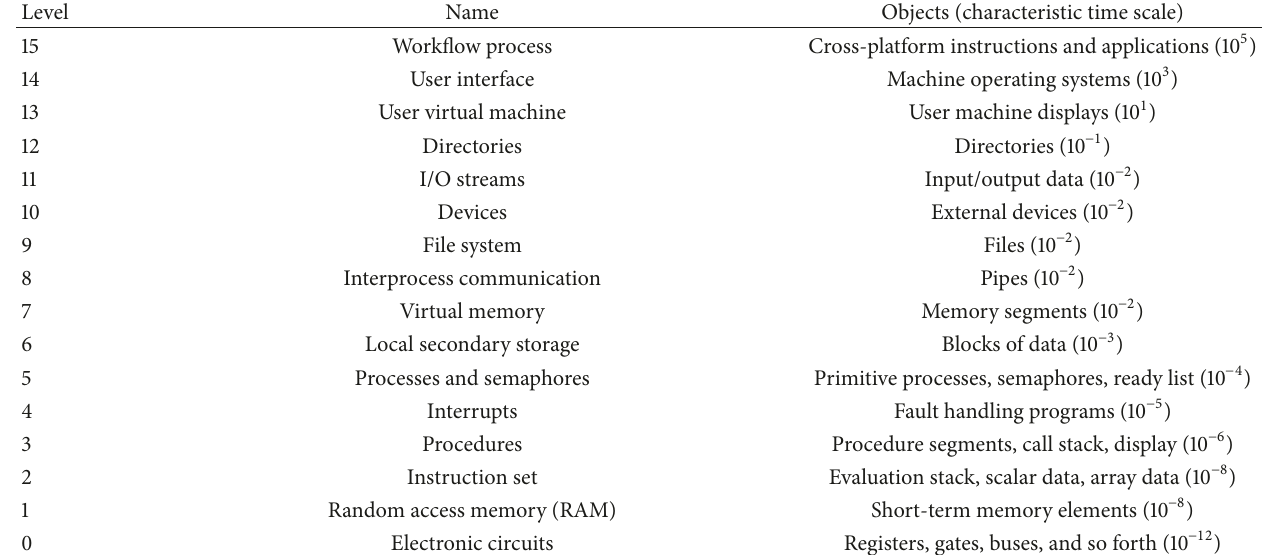
Table 1: Hierarchically compounded components and instruction levels recognizable in most modern computers, with object levels and characteristic time scales of operation in seconds. Adapted from Brown et al. [47] and Denning